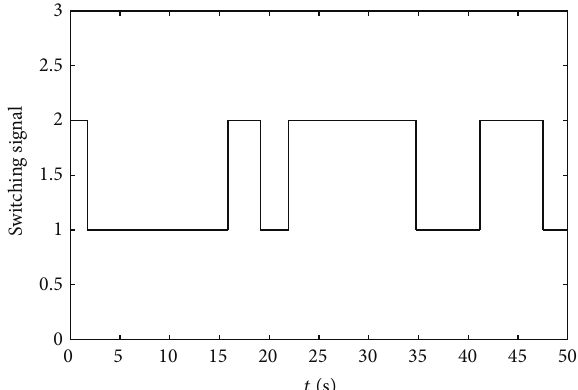
Figure1:Arbitraryswitchingsignalwiththeaveragedwelltime 𝜏 𝑎 = 7 .